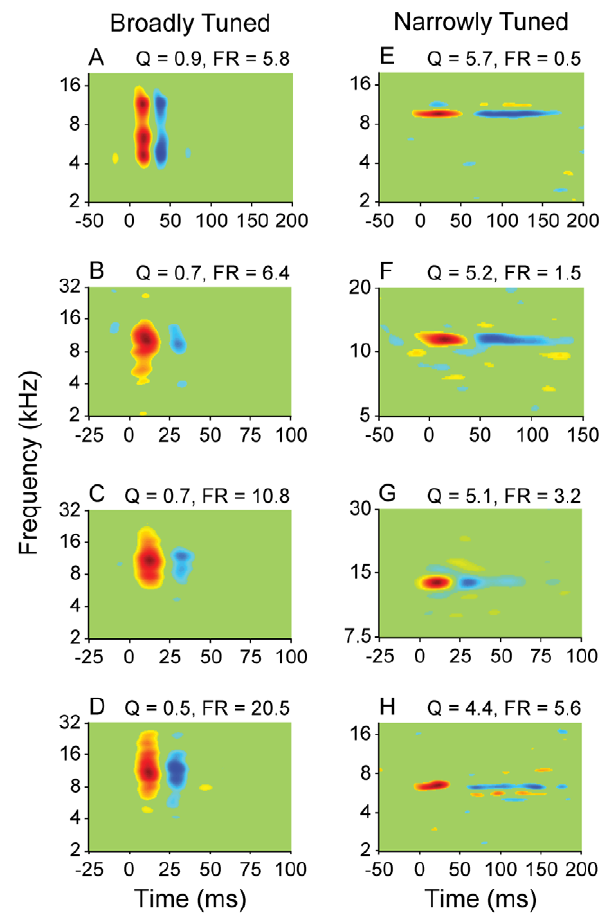
Figure 1. STRFs of broadly and narrowly tuned AI neurons. (A– D) Broadly tuned neurons. (E–H) Narrowly tuned neurons. Q: quality factor, which is the spectral tuning metric. FR: firing rate.